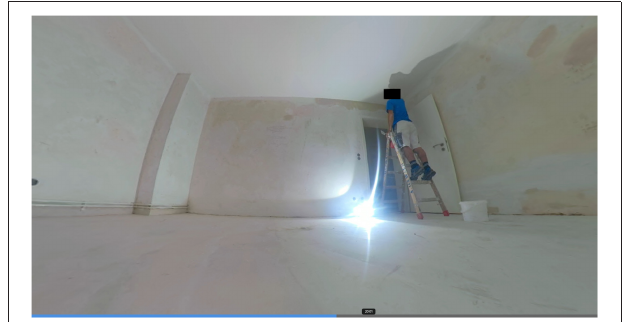
FIGURE 1 | Image of 360 degree capture of plastering worker preparing walls and ceiling.